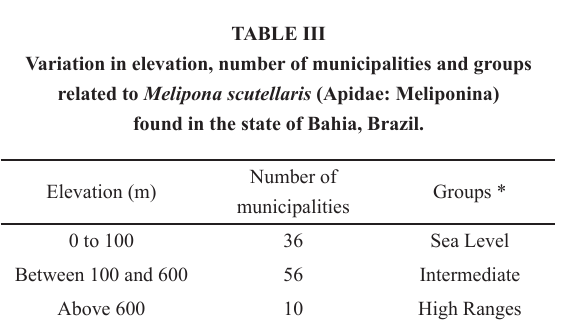
Fig. 3 - Gradient of elevation distribution of Melipona scutellaris in the state of Bahia, Brazil.